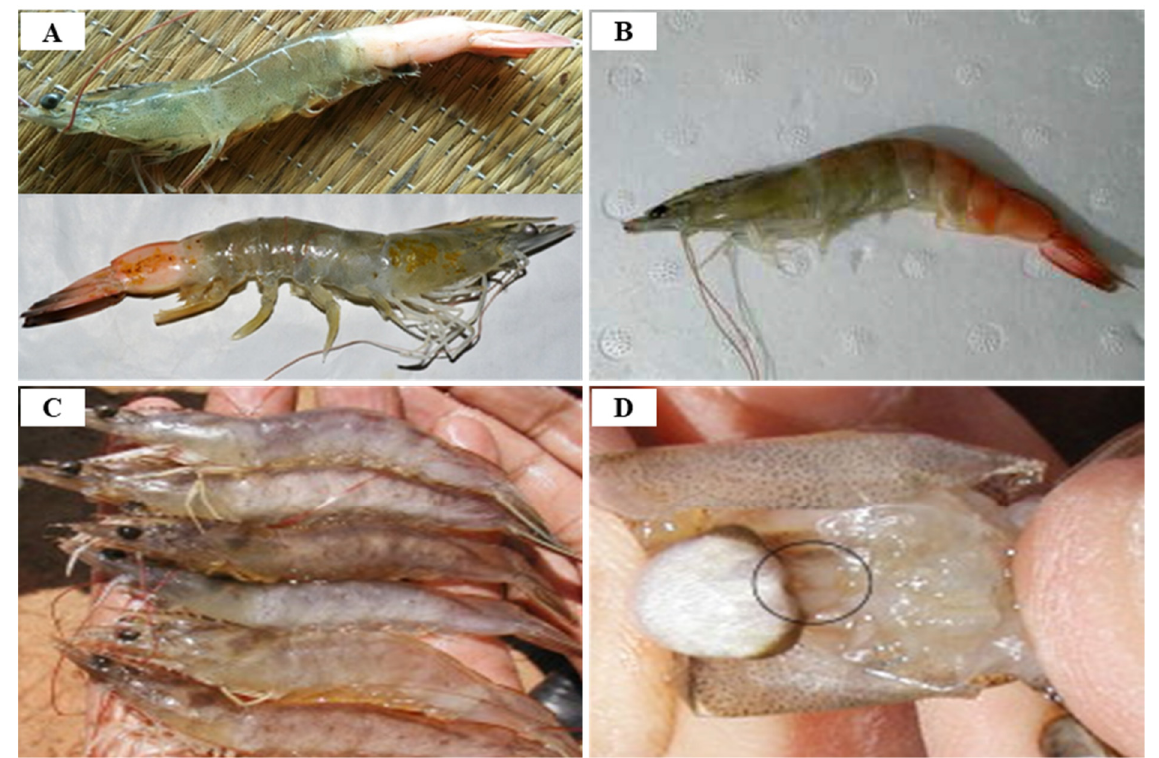
Figure 13. External symptoms of infectious myonecrosis virus (IMNV) on shrimp. ( A ) IMNV-infected Penaeus vannamei with reddish opaque muscles at the distal abdominal segments; ( B ) P. vannamei injected with IMNV propagated in a C6/36 cell line with reddish opaque muscle at the distal abdominal segments as observed in the natural infection; ( C , D ) P. vannamei infected with IMNV and displaying focal to extensive white necrotic areas in the striated muscle, especially of the distal abdominal segments and tail fan, and exposure of the paired lymphoid organs (LO) by simple dissection will show that the paired LO are hypertrophic to twice or more their normal size. (( A ) Reprinted from Journal of Fish Diseases, Vol. 40 (12), Sahul Hameed, A.S., Abdul Majeed, S., Vimal,